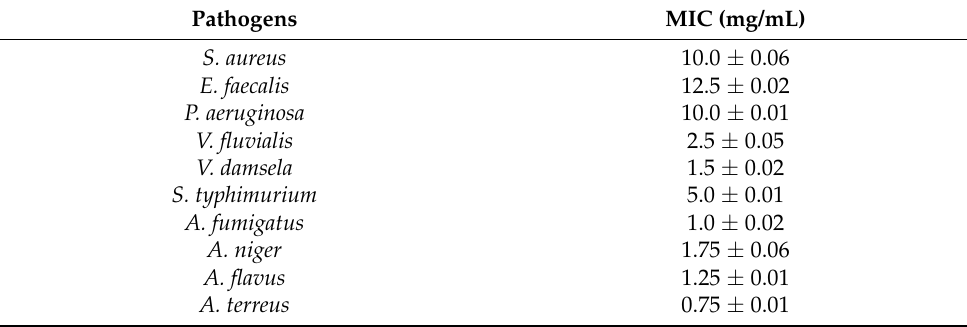
Table 7. MIC values of the ERF against selected